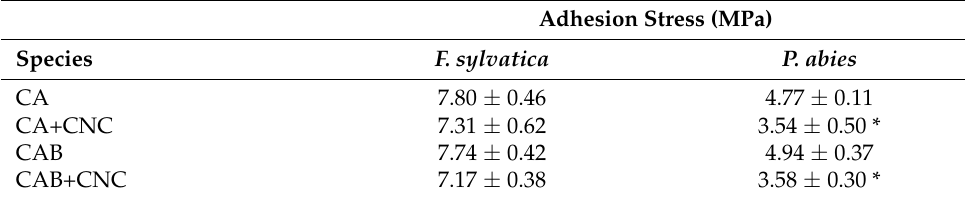
Table 7. Results of the adhesion test (EN ISO, 4624:2016) for the two wood